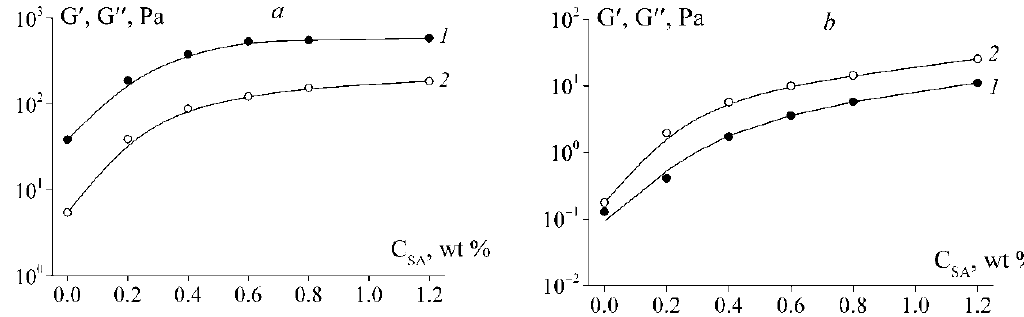
Figure 1. Dependencies of storage G ′ (1) and loss G ′′ (2) moduli on the concentration of sodium alginate C SA in fish gelatin gels at 4 °C ( a ) and 14 °C ( b ). Gelatin concentration is 10 wt%.